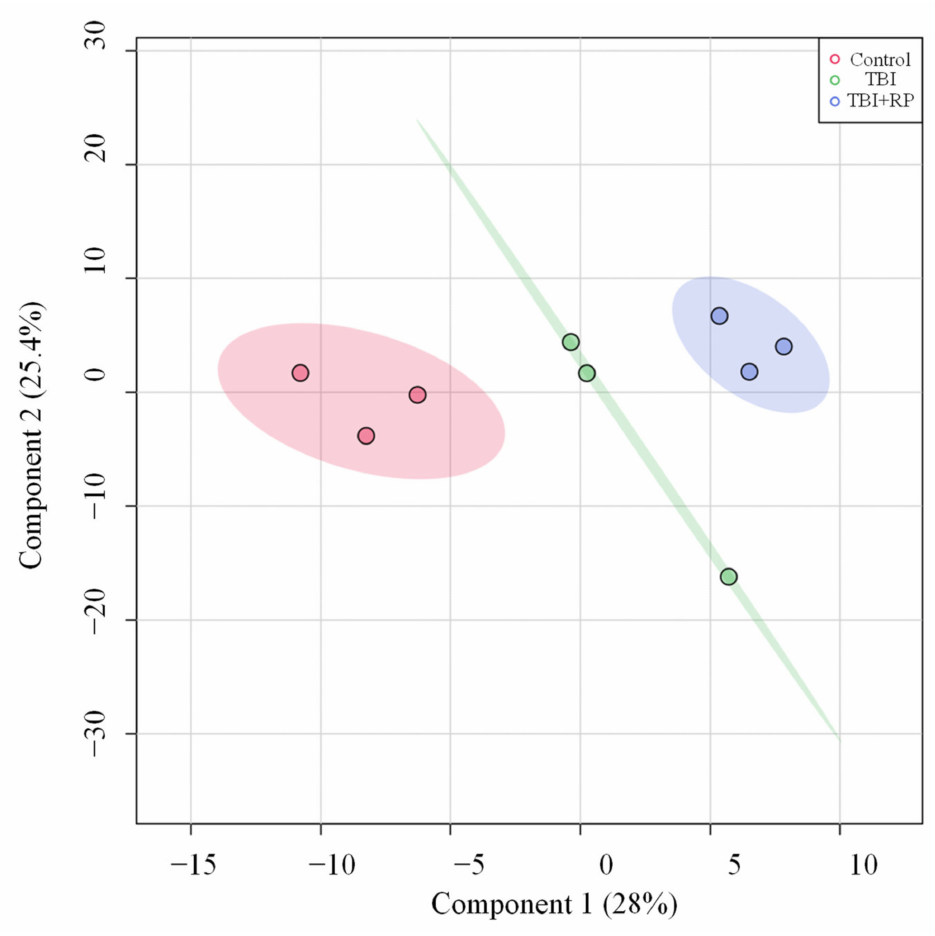
Figure 3. PLS-DA plots of the serum metabolome. PLS-DA plot shows separation for study groups control, TBI and TBI + RP based on metabolic